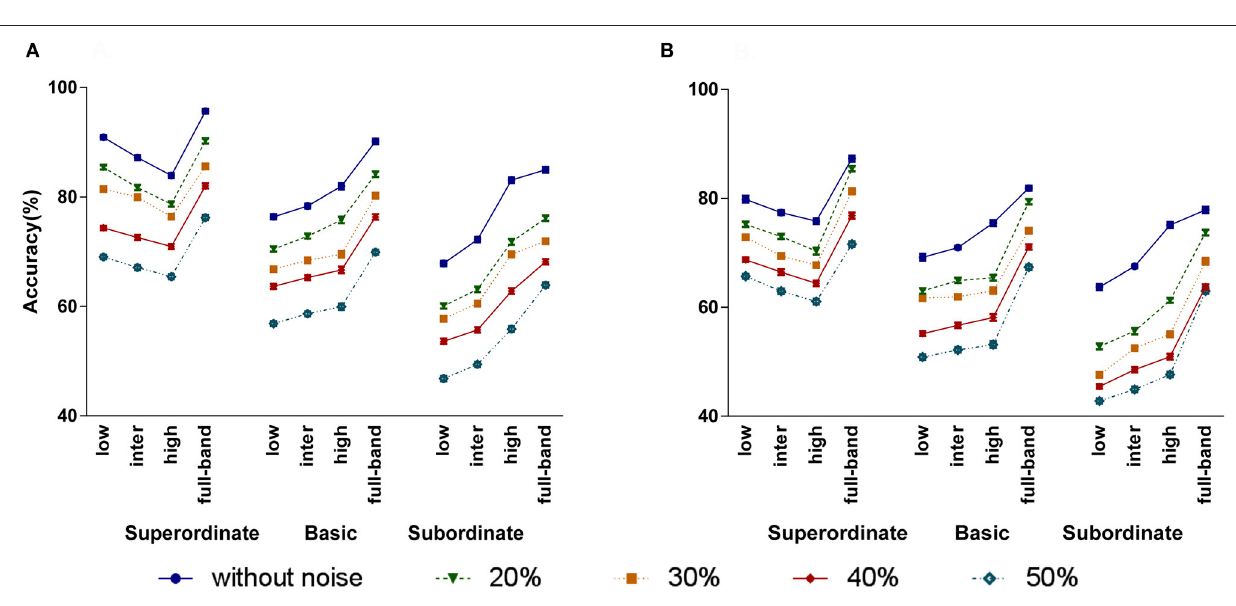
could accurately perform superordinate level